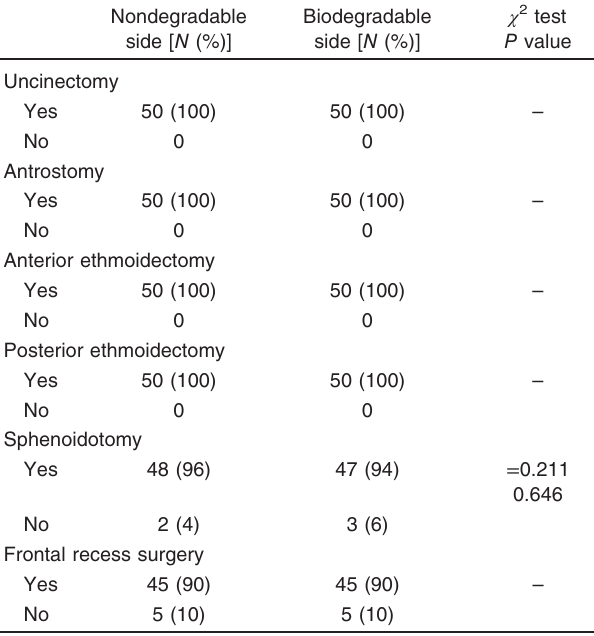
Table 2 Comparison between nondegradable and biodegradable sides regarding the extent of functional endoscopic sinus